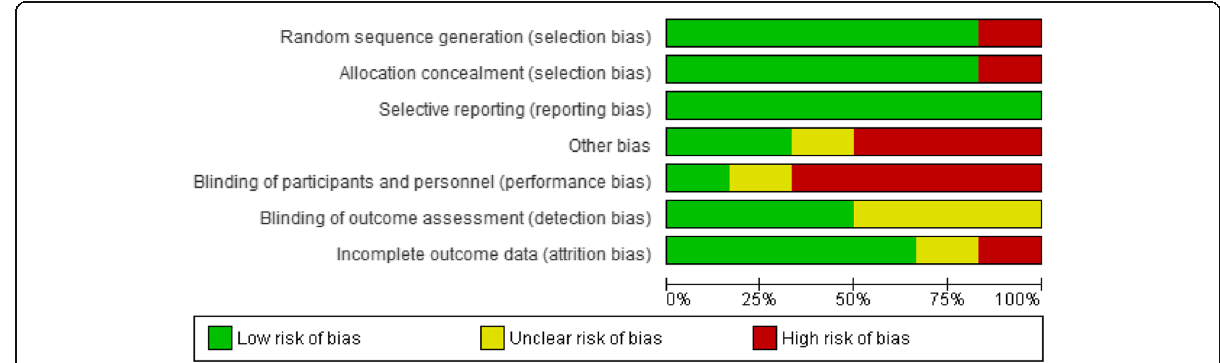
Fig. 2 Risk of bias graph: review authors ’ judgements about each risk of bias item presented as percentages across all included studies (Risk of Bias